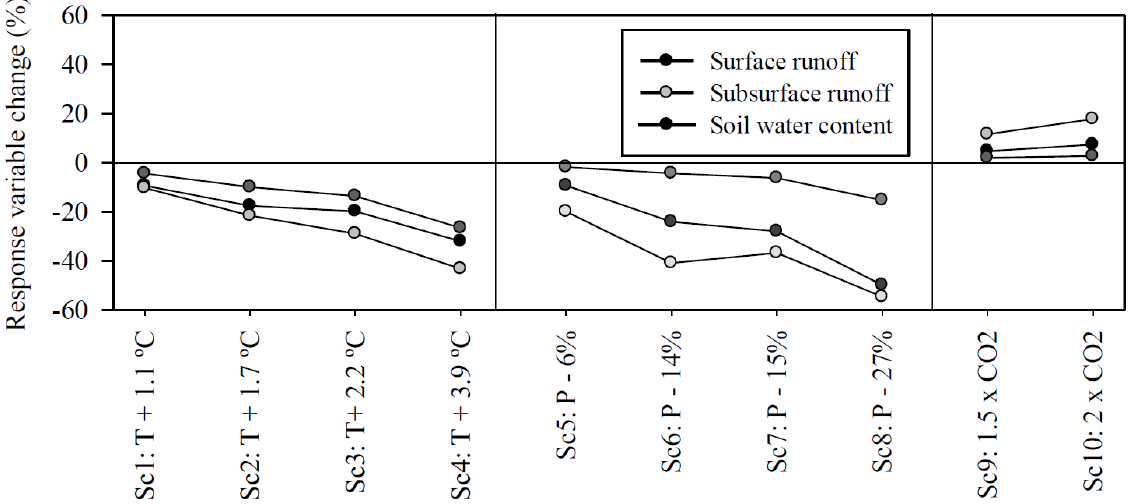
Figure 6. Response of different flow components and soil water content to changes in temperature, rainfall and CO 2 concentration based on the scenarios defined in Table